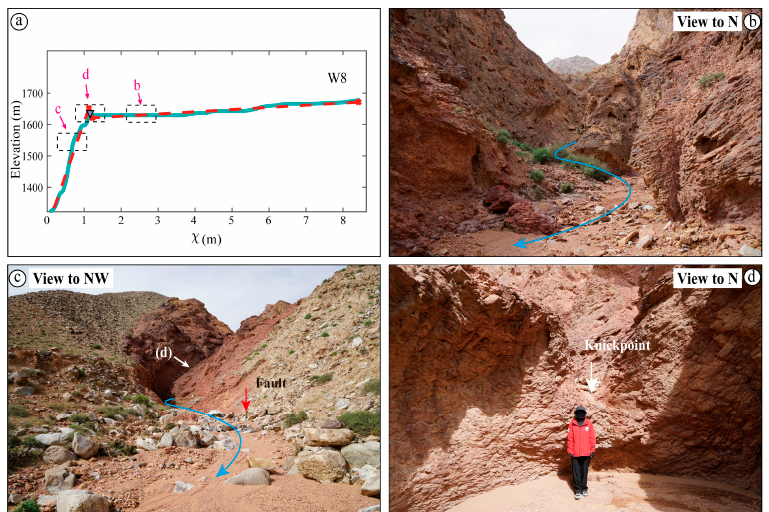
Figure 10. River longitudinal profile and field photographs of watershed 8. ( a ) Channel longitudinal profiles of watershed 8. Photographs of the river channel in the ( b ) upper reach, ( c ) down reach and ( d ) knickpoint. The black boxes and purple fonts in ( a ) indicate the locations in the river channel where the photographs ( b – d ) were taken. The blue lines in ( b , c ) show the river direction. The red and white arrows in ( c ) and white arrow in ( d ) indicate the fault, the location where the photograph ( d ) was taken and the knickpoint, respectively.